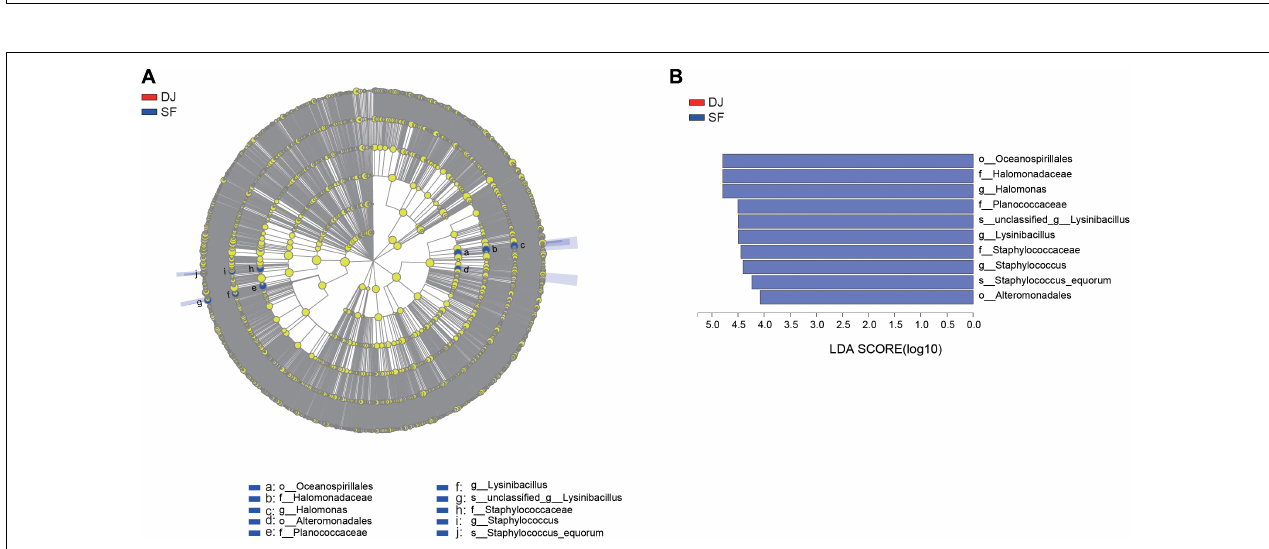
FIGURE 6 | LEfSe comparison of bacterial communities in Dajiang and Sufu. (A) Cladogram representing the abundance of bacterial taxa in Dajiang and Sufu. (B) Histogram depicting the microbiota in Dajiang and Sufu with a threshold value of 4.